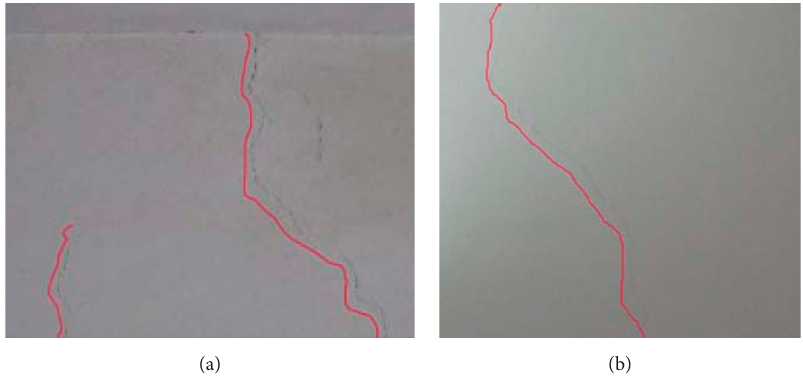
Figure 7: Cracking of infilled walls.